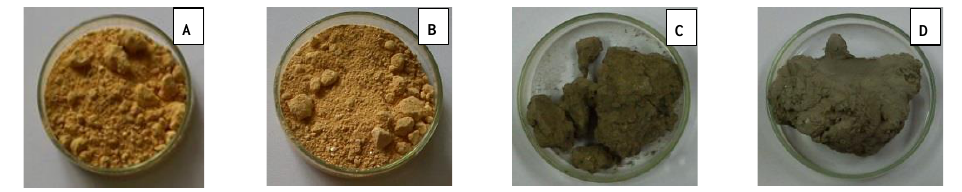
Figure 1. The granitic residual soil (( A ) Broga granitic residual soil, BGR and ( B ) Kajang granitic residual soil KGR) and marine clay (( C ) Sg Besar marine clay, SBMC1 and ( D ) SBMC2) used in this study. Petri dish size are 35 mm.